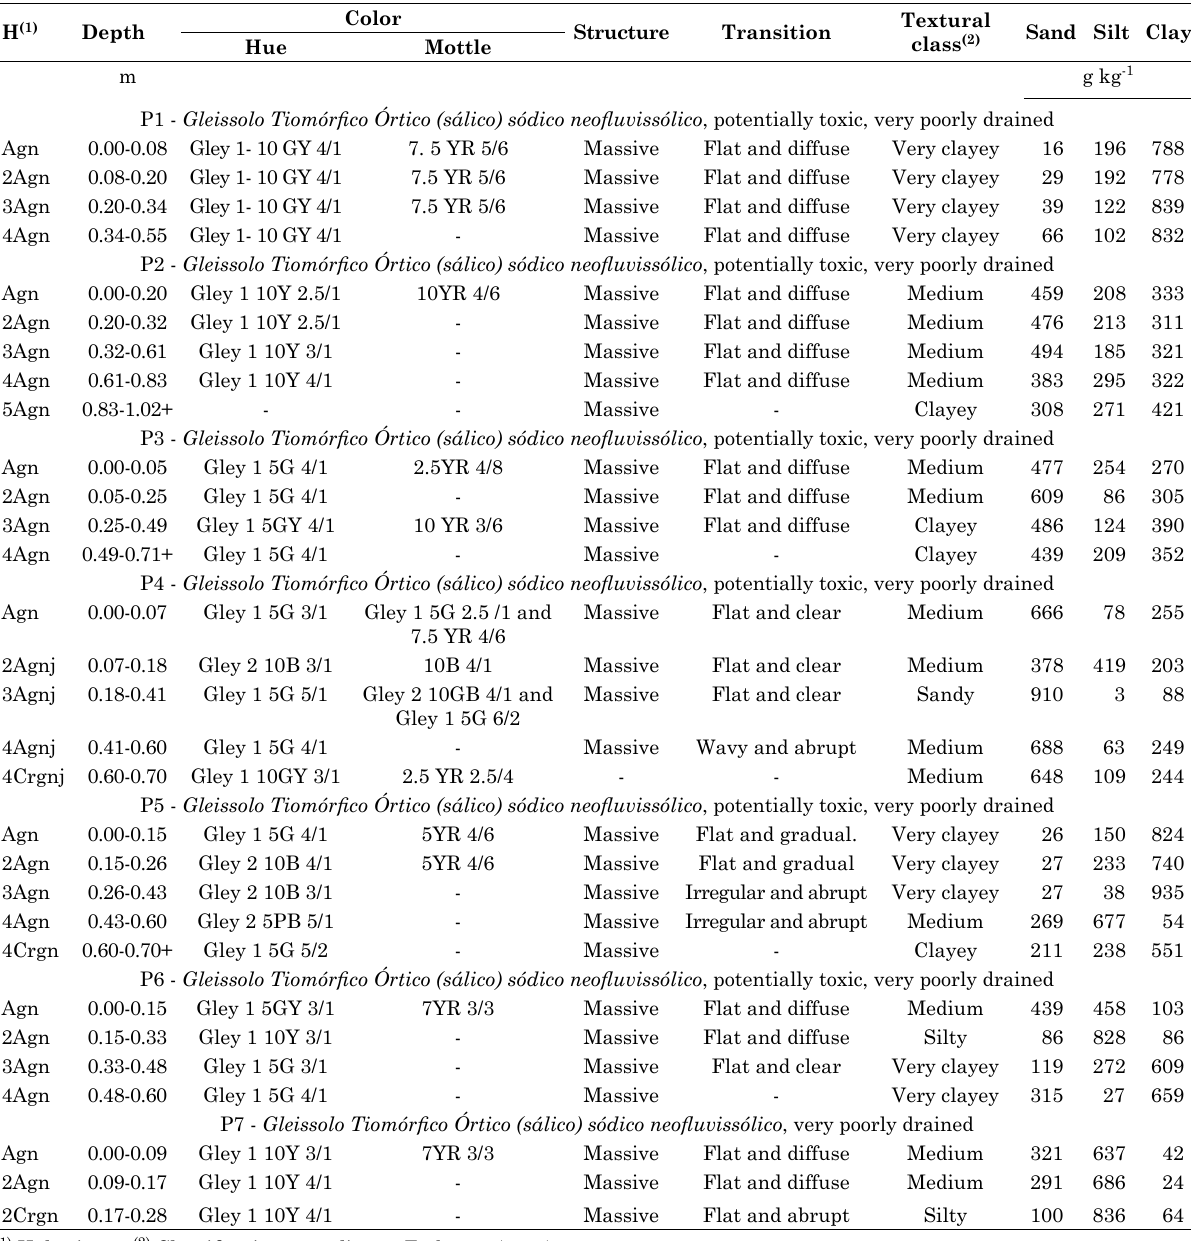
Table 1. Morphological and physical properties of pedons from mangrove soils in the Subaé river basin, Santo Amaro, Bahia,